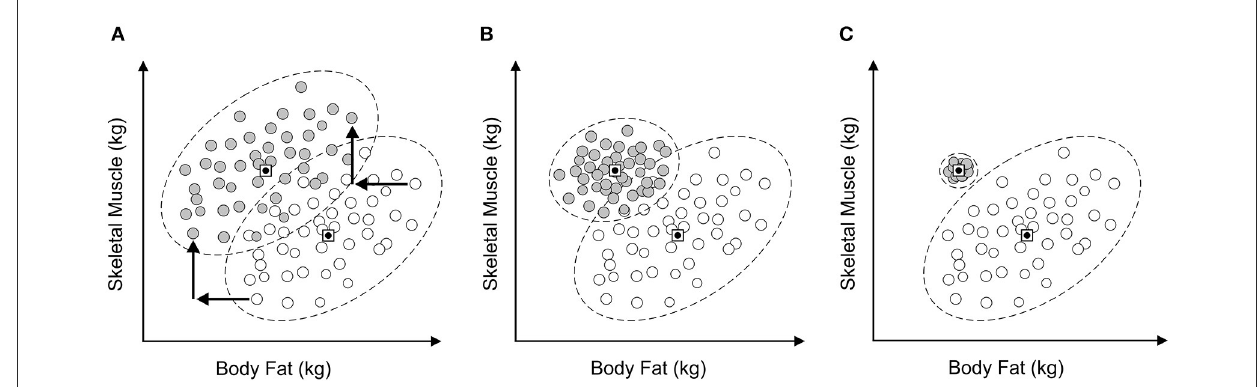
FIGURE1 (A–C) Three alternative ways that estimates of current body composition and body ideals are potentially related in 2D muscle-fat space. White circles represent estimates of body composition, filled circles represent ideal body composition.